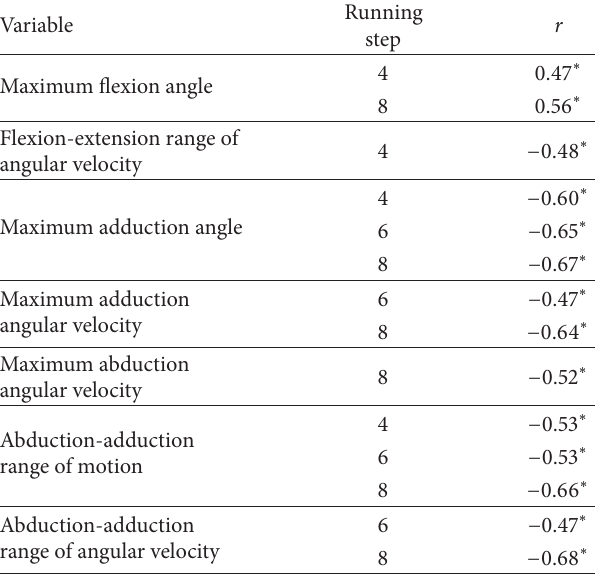
Table 1: Values of correlation coefficients ( r ) between running time over a 10-meter section and individual kinematic variables of the hip